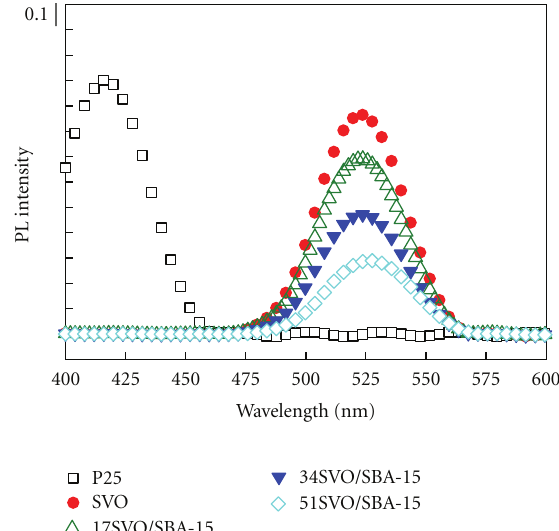
Figure 8: Normalized PL intensity of the samples measured at 300